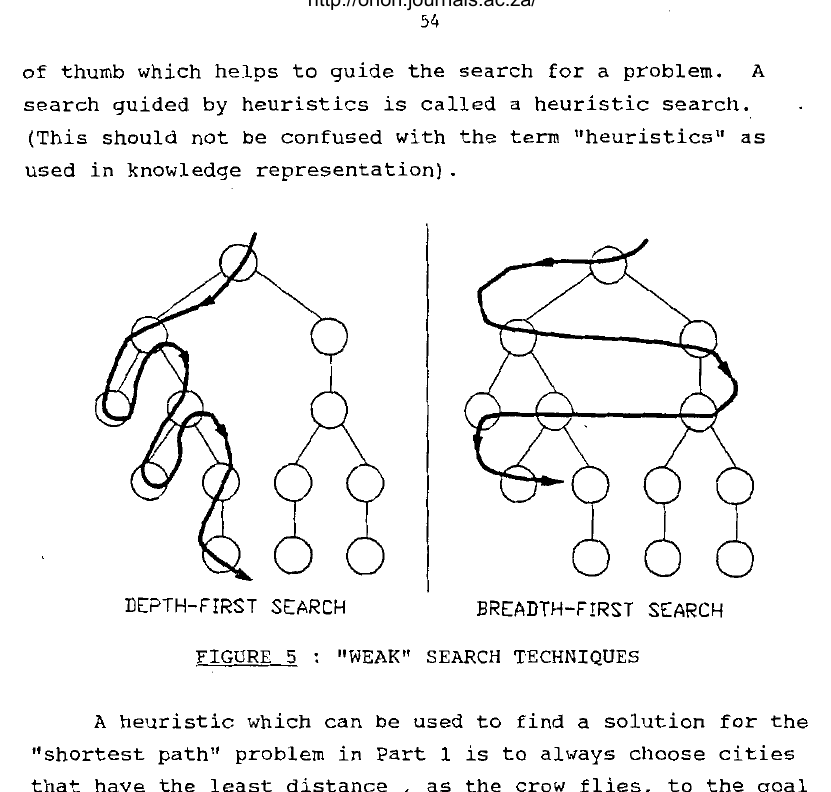
FIGURE 5 : "WEAK" SEARCH